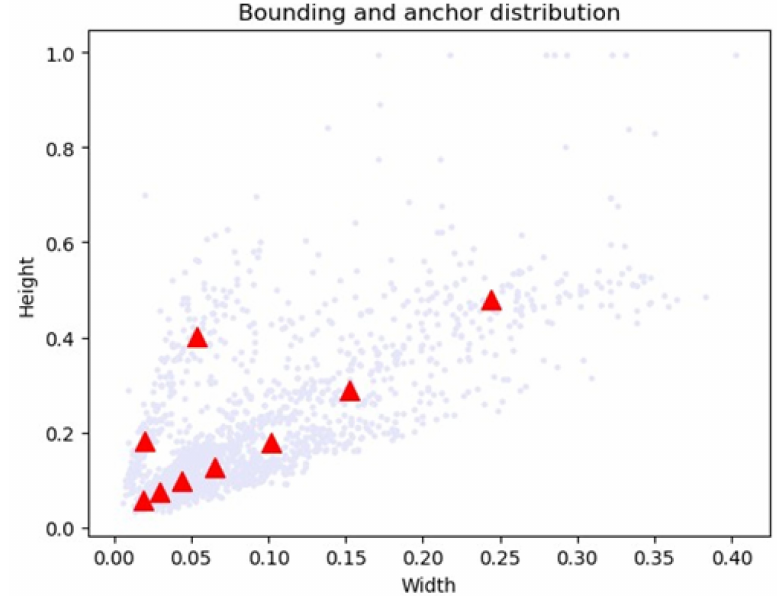
Figure 8. Anchor